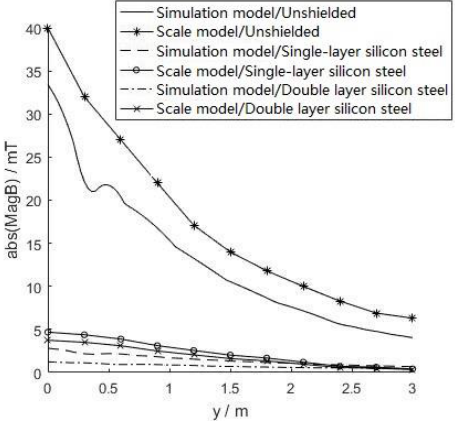
Figure 20. Central axial magnetic induction distribution with shielding.